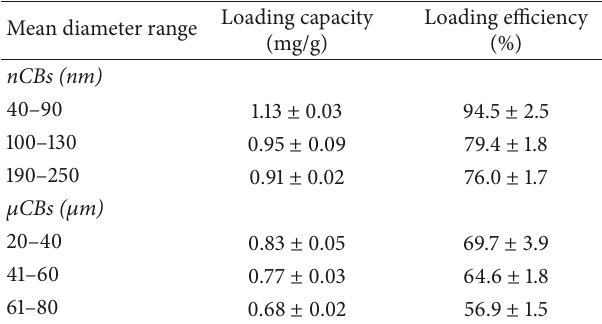
Table 1: Effect of mean diameter range of cellulose beads on loading capacity and efficiency of curcumin.